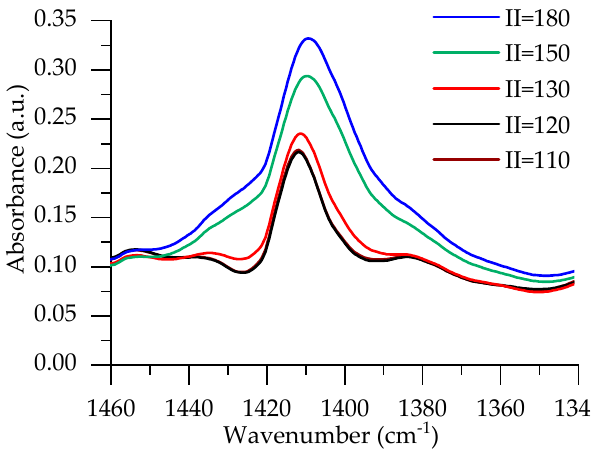
Figure 2. FTIR spectra for RO / PET rigid PUR foams, band at 1410 cm − 1 .